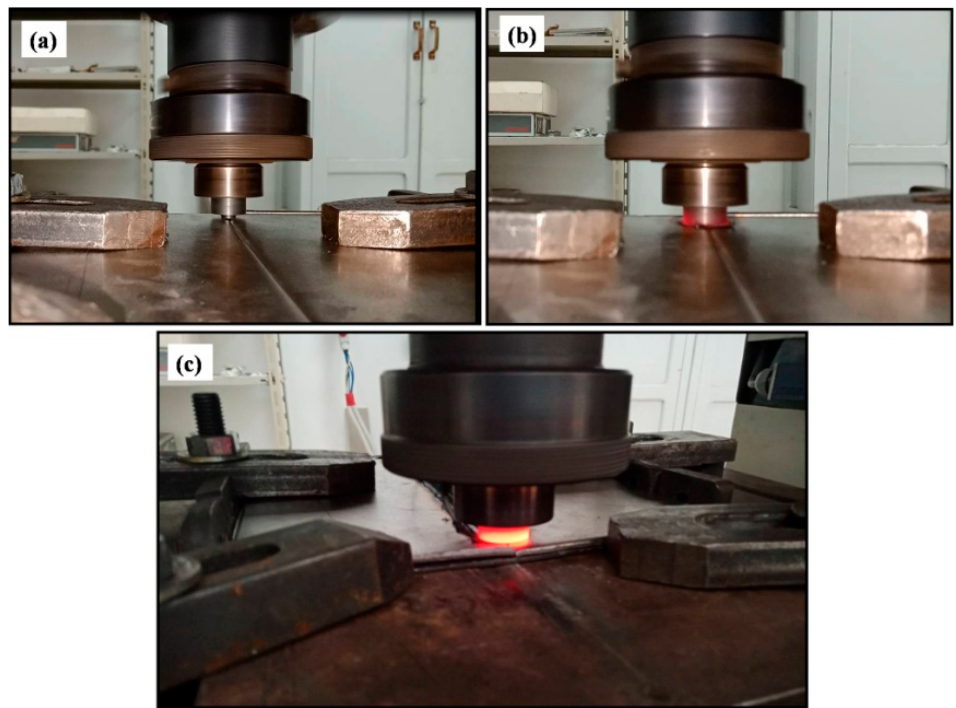
Figure 3. A schematic of the FSW process, indicates the process’s main characteristic features. The FSW tool is shown with the exit hole just below the tool after extraction.